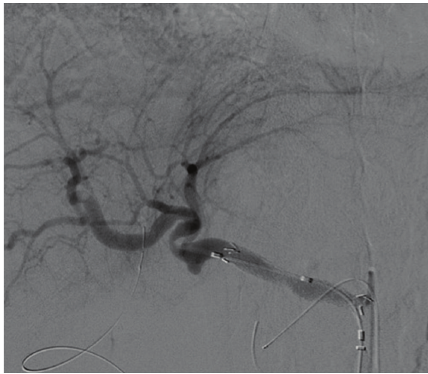
Figure 2: Angiography shows successful placement of the stent graft.